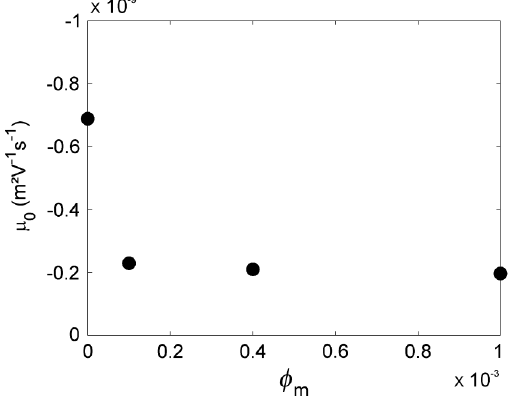
V ¼ 0 at dc m . The red